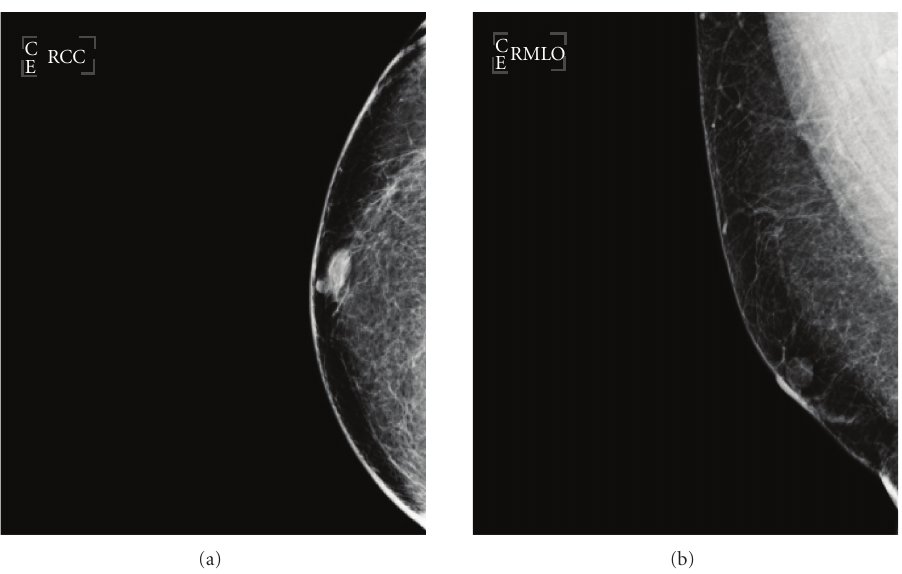
Figure 1: Mammography: Right breast CC & MLO Views: Isodense, well-defined lesion within the retroareolar area 18 × 13 mm in diameter.